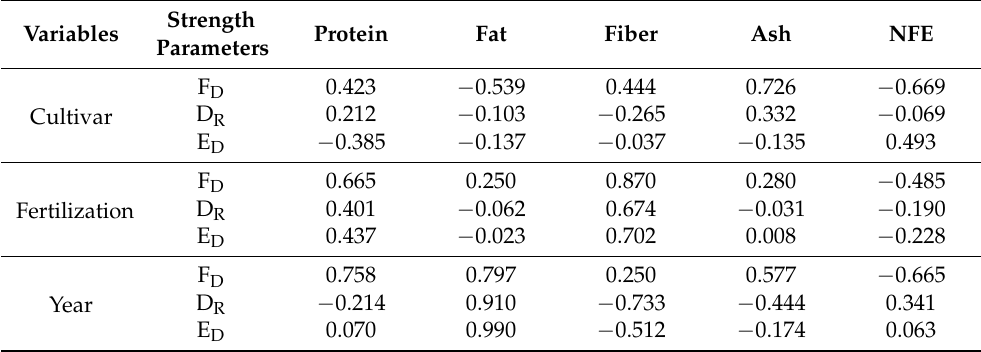
Table 6. Correlation coefficients (r) between the strength parameters of pea seeds and the content of macronutrients in seeds. Strength Phosphorus Potassium Calcium Magnesium Sodium Variables Parameters P K Ca Mg Na F D − 0.095 0.164 Cultivar − 0.482 − 0.396 − 0.183 − 0.480 0.269 F D −